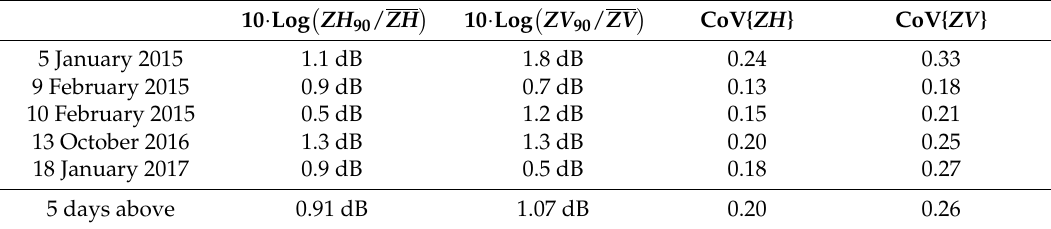
Table 4. Dispersion of the radar reflectivity values ( Z ) for Horizontal ( H ) and vertical ( V ) polarization: Log-transformed ratio between the 90 percentile and the average (columns 2 and 3); ratio between the standard deviation and the average linear value of Z (columns 4 and